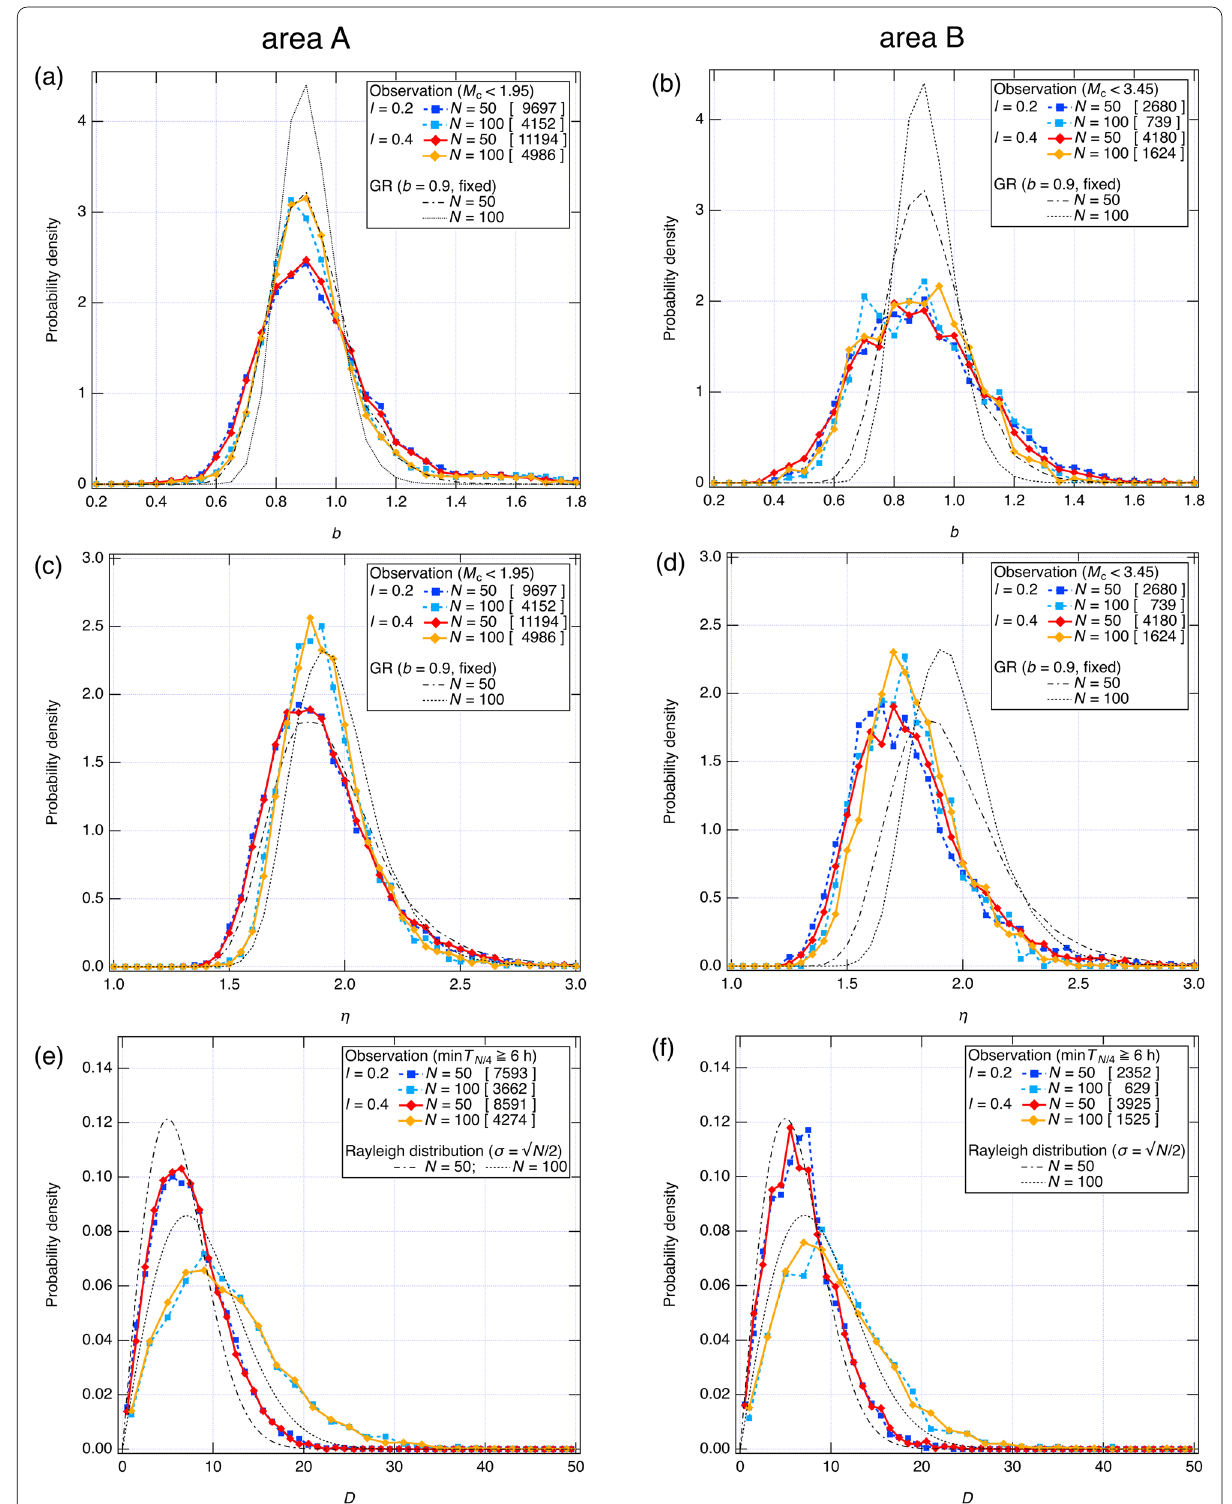
Fig. 5 Probability density distributions of each index value. Numbers in square brackets in the legend indicate the number of estimated index values. a , b b ; c , d η ; e , f D . Left, area A; right, area B. The black lines in a – d are the distributions expected from the GR law where the true value of b is constant at 0.9. The black lines in e and f are the distributions expected when no tidal correlation